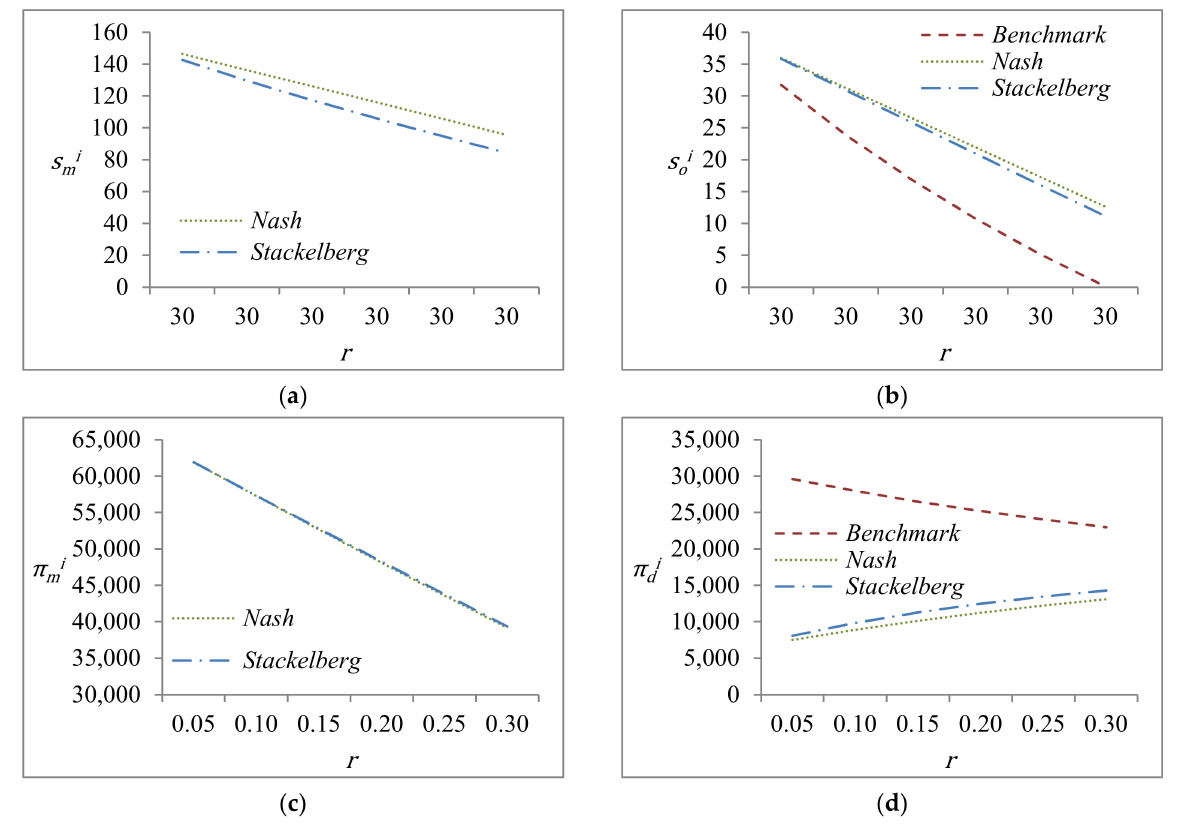
Figure 2. Effect of online store’s rate of return on: ( a ) manufacturer’s decision; ( b ) retailer’s decision; ( c ) manufacturer’s profit; ( d ) retailer’s profit. The following market condition is used: r = variable , r r = 0.2, ε = 0.005, h = 30, α m = α o = α r = 100, γ = 0.9, γ r = 0.2, p = 600, v r = 400, v o = 20, c d = 420, c m = 100, ∅ =